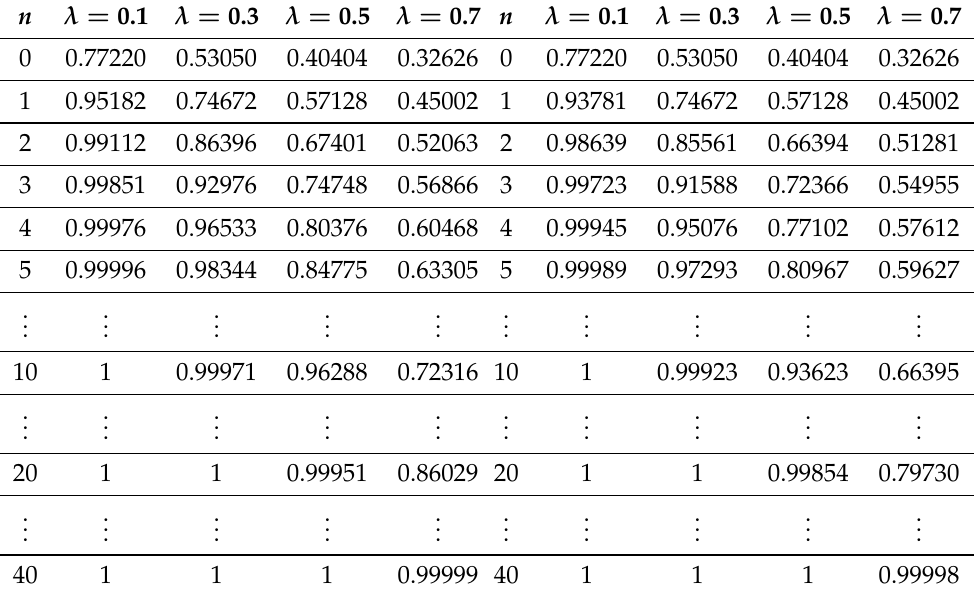
Table 3. The distribution function of the maximum queue length ¯ Q f max , n as λ varies for PS1 and